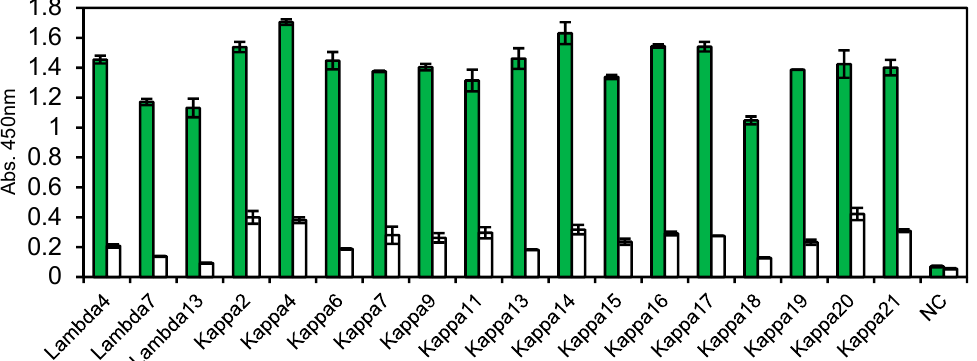
Figure 5. ELISA results of the cell-free products obtained from human B cells. Green: Influenza vaccine, White: BSA. Error bars indicate standard deviations.